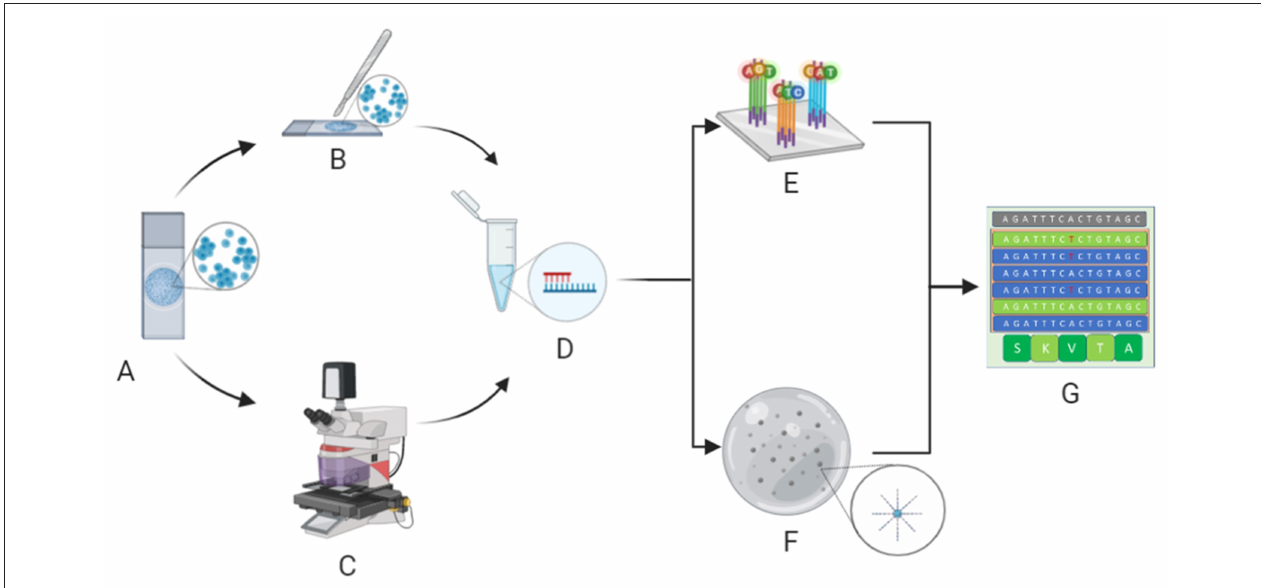
FIGURE 1 | Molecular cytopathology workflow. After microscopy, evaluation of neoplastic cell content whilst avoiding contaminants (A) is carried out by manual dissection of cytological samples (B) or, in particularly difficult cases, laser microdissection (C) before extraction of nucleic acids (D) . Extracted DNA/RNA is adequately adopted for next generation sequencing analysis, specifically hybrid-capture-based (E) or amplicon-based (F) platforms, to define the molecular status of clinically relevant biomarkers (G) . (Credit: Created with Biorender.com).